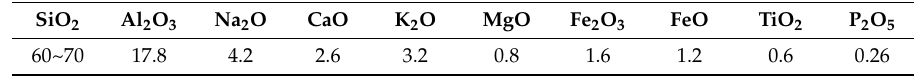
Table 2. The chemical composition of natural zeolite (wt%).